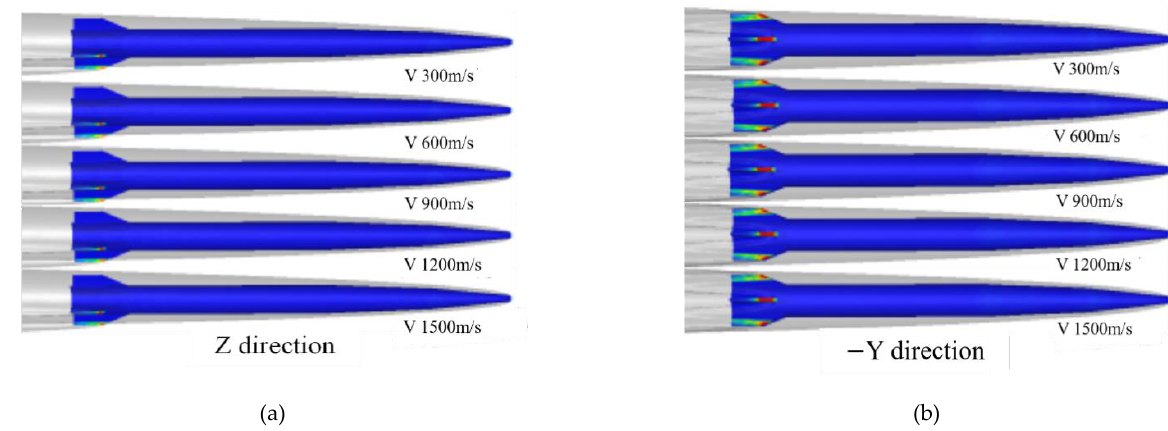
Figure 9. Cavitation morphology with different flow speeds in the directions of ( a ) Z and ( b ) – Y, respectively. (attack angle 1°).